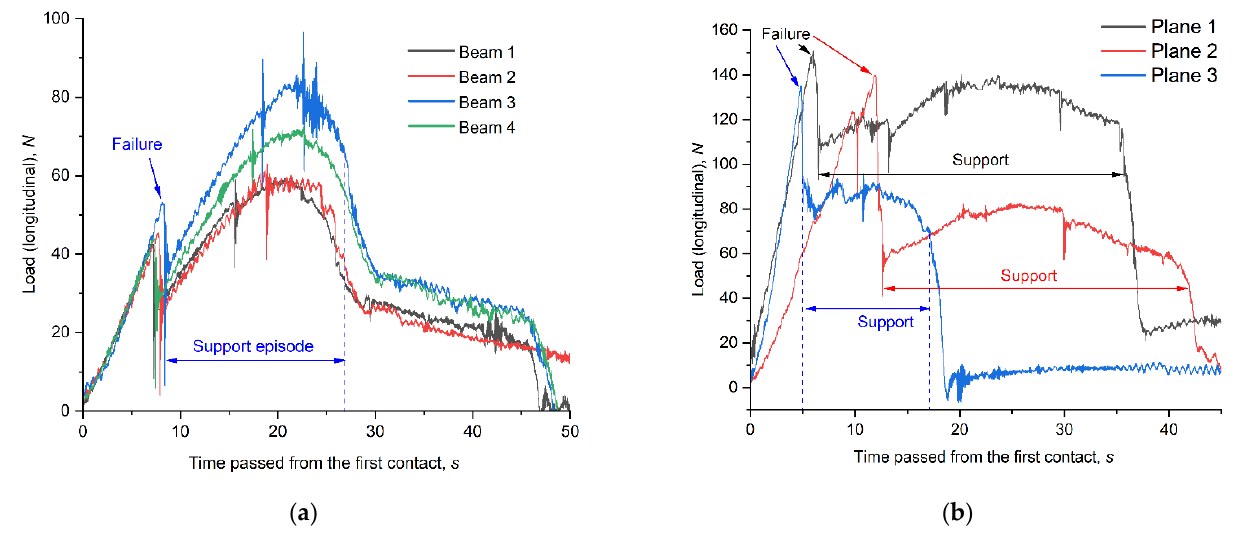
Figure 9. Longitudinal loads recorded: ( a ) at velocity of 2.5 mm/s in experiments with Beam 1 (black), Beam 2 (red), Beam 3 (blue), and Beam 4 (green); ( b ) in experiments with ice planes at velocity of 2.5 mm/s, Plane 1 (black), Plane 2 (red), and at velocity of 5 mm/s, Plane 3 (blue).